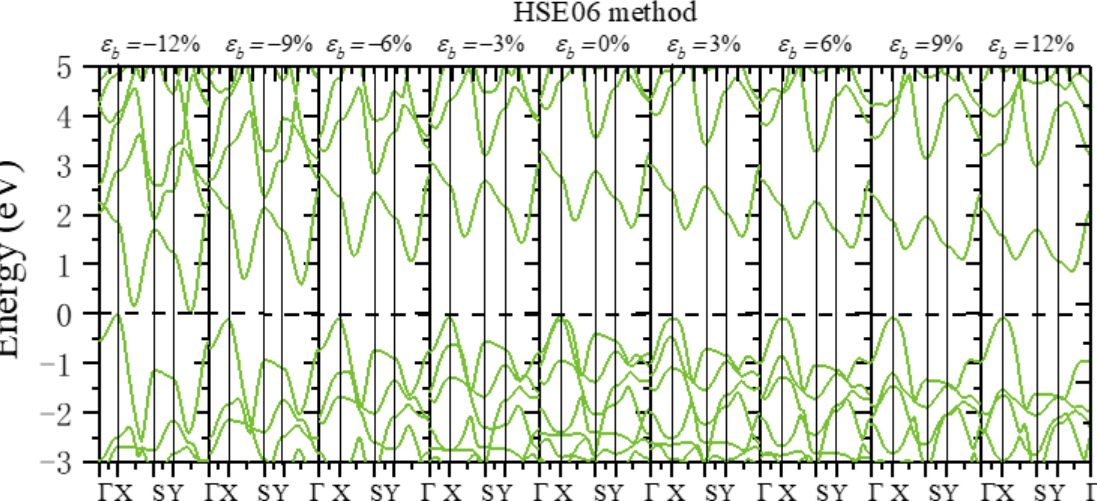
Figure 9. The band structure when different uniaxial strains along b -direction were applied using the HSE06 method.